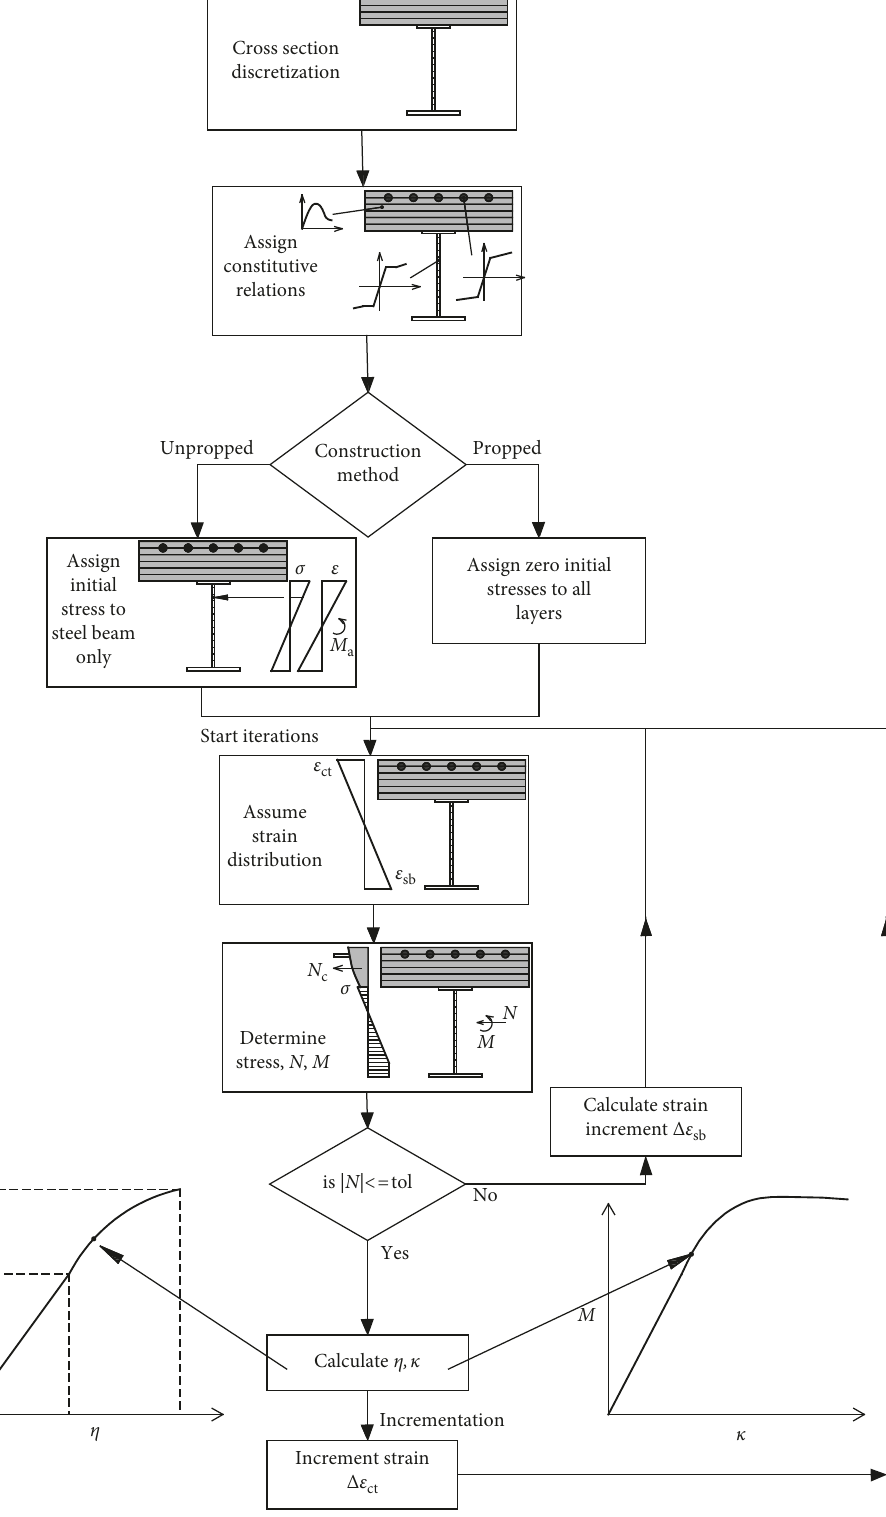
Figure 6: Algorithm of the nonlinear section